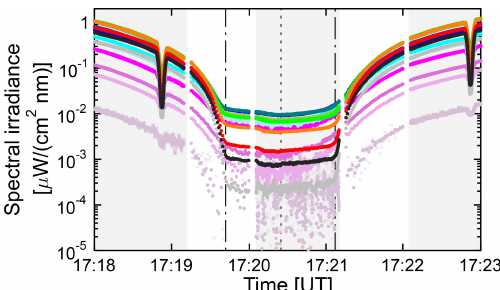
Figure 14. Spectral irradiance measured between about 1.5min be- fore the second contact and about 2min after the third contact. The color coding is identical with that used in Fig. 8. Grey shading in- dicates times of shadowbanding. The times of the second and third contact are indicated by dotted–dashed lines, and the short-dashed line marks the time of maximum